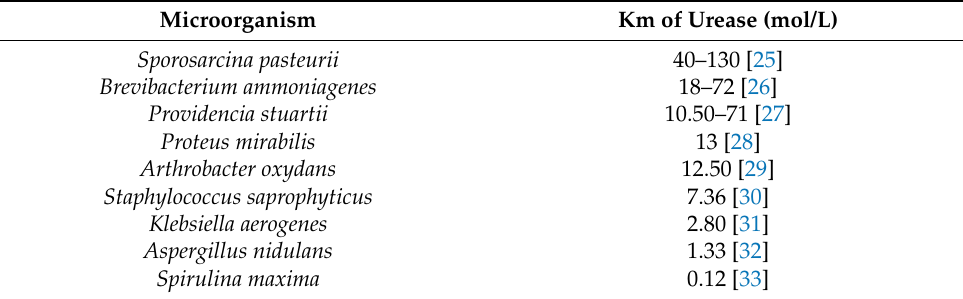
Table 1. Urease activity of different